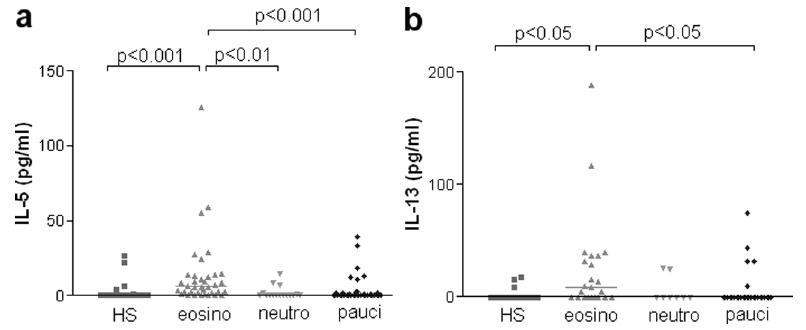
Figure 3. IL-5 and IL-13 levels in asthmatics according sputum cellular profile.